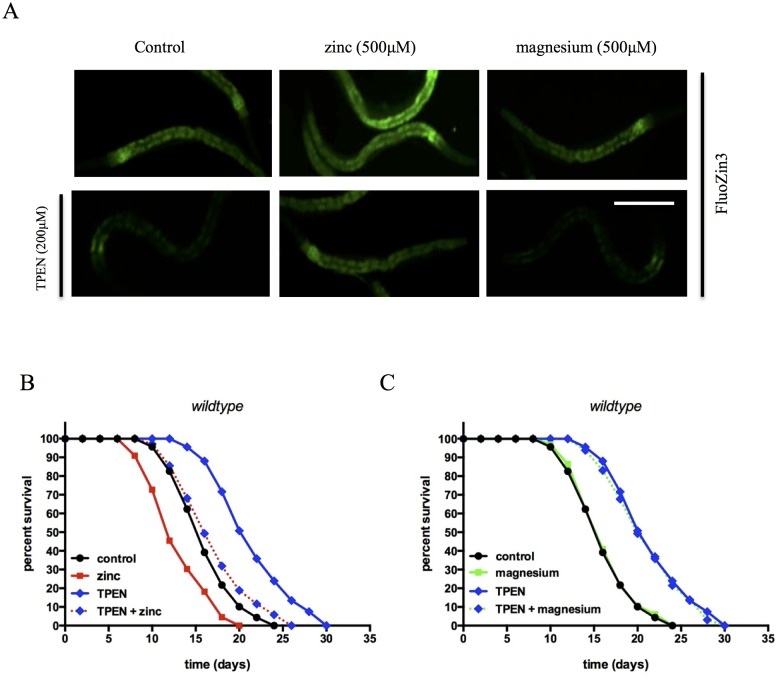
TPEN effects on C. elegans metal content and lifespan are zinc-specific.(A) TPEN effect on labile zinc levels is specific to the chelation of zinc. Wildtype worms were exposed to 200μM TPEN in the presence or absence of 500μM ZnSO4 or 500μM MgSO4 at L3 stage and collected at one-day old adult animals for analysis of relative labile zinc content. The representative micrograph shows that worms supplemented with zinc have elevated labile zinc content, while TPEN treatment decreased labile zinc. Equal molar levels of magnesium had no effect on basal or TPEN-induced fluorescence. Scale bar = 0.2mm. (B) Kaplan-Meier survival curve of worm populations exposed to zinc and/or TPEN. Wildtype worms were exposed to 200μM TPEN in the presence or absence of 500μM ZnSO4 at the L3 stage and monitored for effects on lifespan. Mean and maximum population lifespan were reduced with zinc supplementation and increased with TPEN treatment (p < 0.0001, log rank test). Additional 500μM ZnSO4 attenuated the effect of TPEN on mean and maximum lifespan. (C) Kaplan-Meier survival curve of worm populations exposed to magnesium and/or TPEN. Wildtype worms were exposed to 200μM TPEN in the presence or absence of 500μM MgSO4 at the L3 stage and monitored for effects on lifespan. Mean and maximum population lifespan were increased with TPEN treatment (p < 0.0001, log rank test). Addition of MgSO4 had no effect on mean and maximum lifespan.